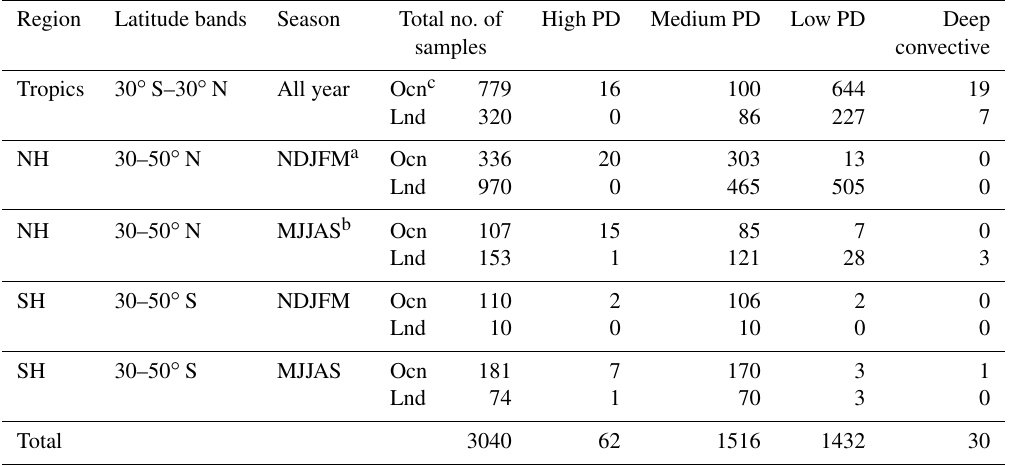
Table 1. Collocation statistics are as follows: total number of samples for each latitude band, season, surface condition (top: ocean and coastal; bottom: land) and scenario regime for March 2014–October 2017. Note that total samples do not include collocations that are clear sky or out of the boundaries of our definition of the four